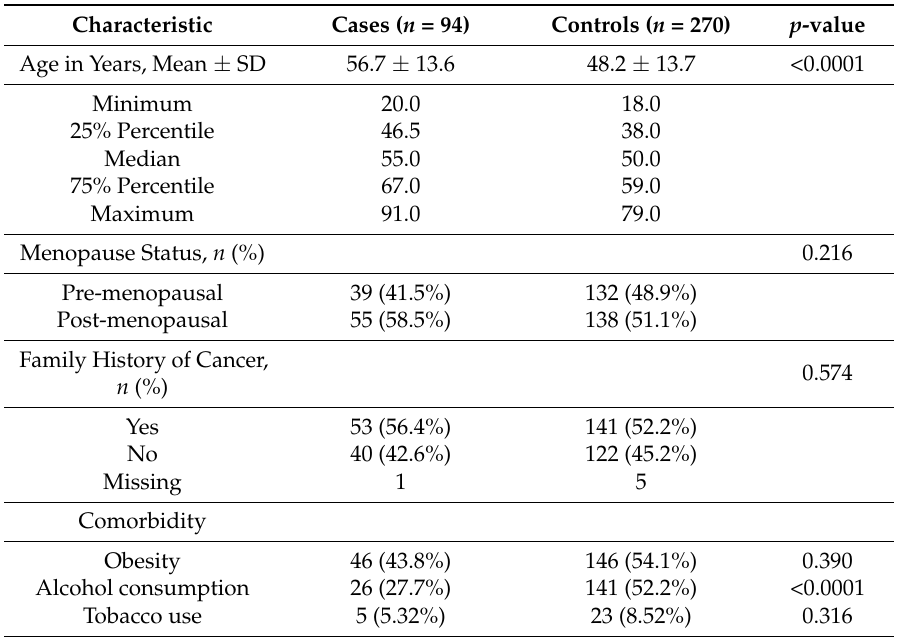
Table 1. Demographic and characteristics of study